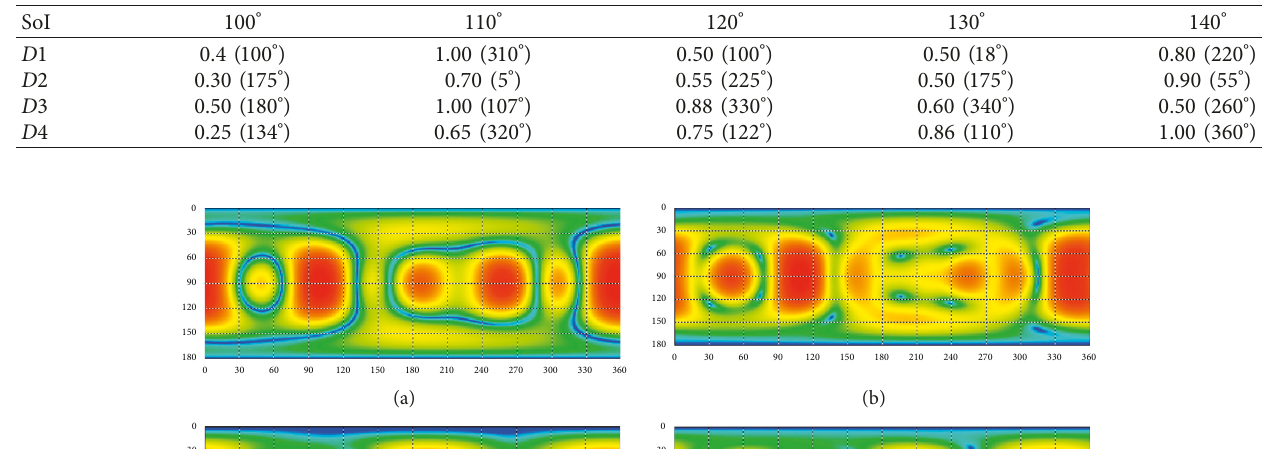
Table 1: The excitation weight, I